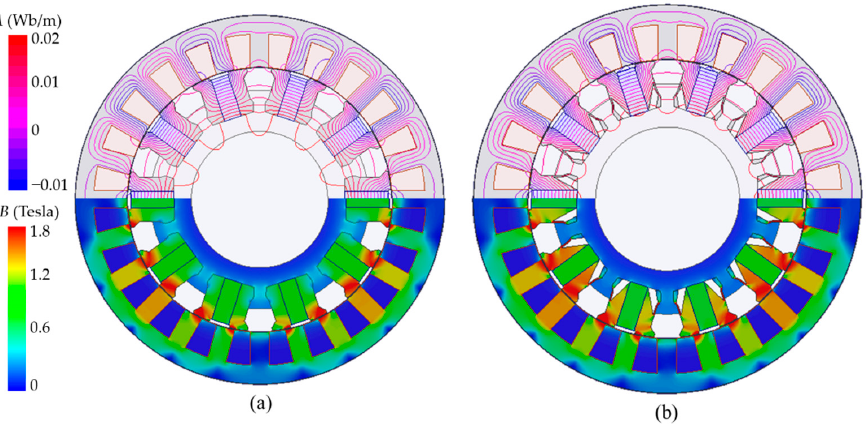
Figure 8. Magnetic flux distribution of ( a ) the conventional structure and ( b ) the optimal structure of RPM-FS machines.